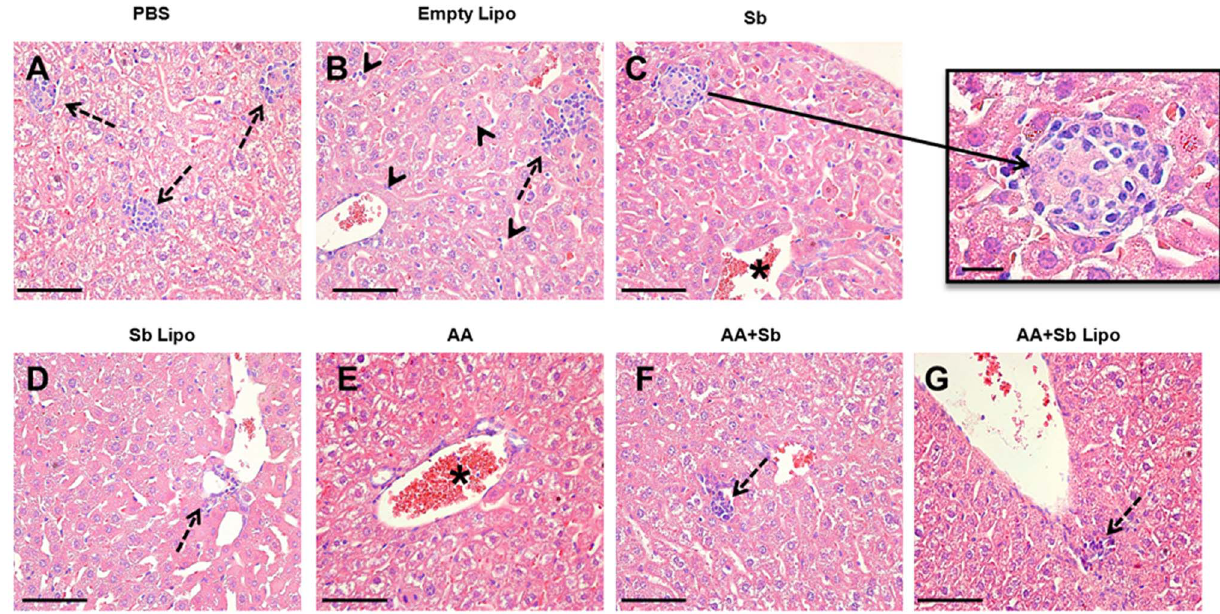
Figure 3. Histopathological analyses of the liver from L.infantum infected mice submitted to different treatment regimens. (A) Phosphate-buffered saline (PBS). (B) Empty liposomes (Empty Lipo). (C) Trivalent antimony (Sb). (D) Antimony entrapped liposomes (Sb Lipo). (E) Ascorbic acid (AA). (F) Ascorbic acid in association with antimony (AA + Sb). (G) Ascorbic acid in association with antimony entrapped liposomes (AA + Sb Lipo). Bar =50 m m. Insert =25 m m, representing an immature granuloma. Dashed arrow = Inflammatory cell foci. Arrowhead = Kupffer cells exhibiting hypertrophy. * Hyperemic vessels.